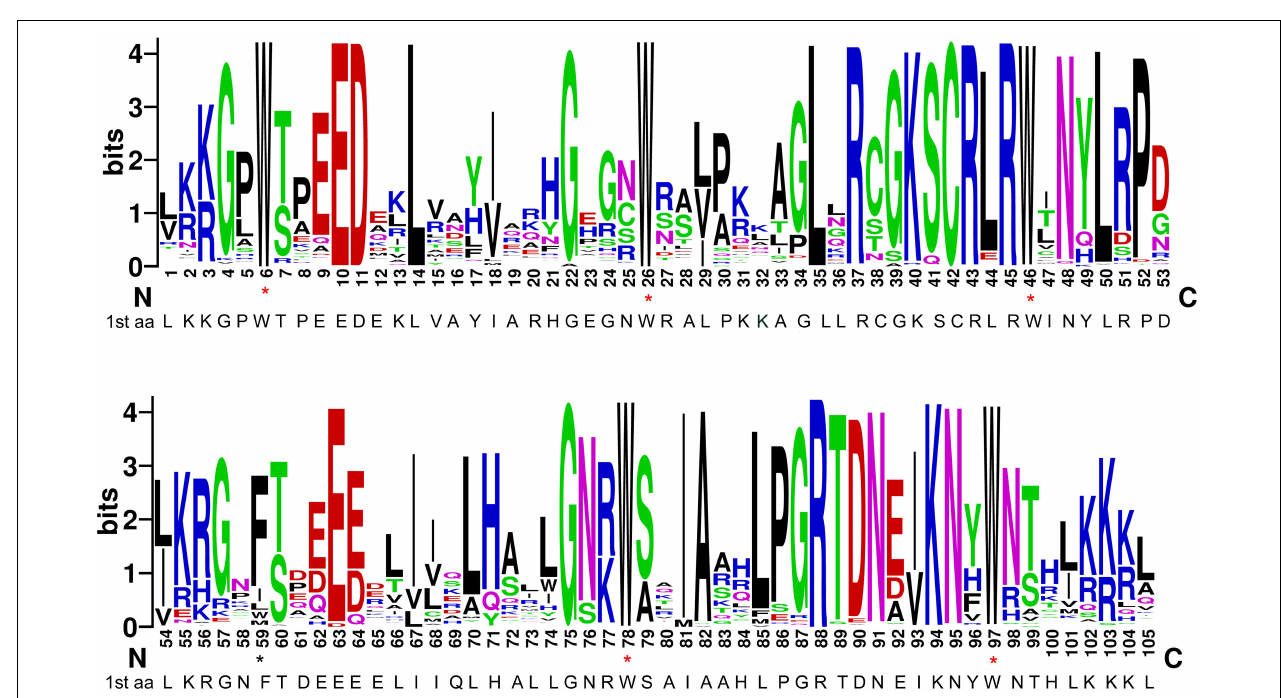
FIGURE 1 | Consensus sequence and level of conservation of R2R3-MYB domains from durum wheat. The sequence logos of the R2 and R3 MYB repeats are based on full-length alignments of all domains. The height of each stack designates sequence conservation at that position and the bit score indicates the relative frequency of the corresponding acid. Conserved tryptophan residues (W) in the MYB domain are marked with red asterisks. Black asterisk highlights the position of the first canonical W in the R3 repeat replaced by hydrophobic phenylalanine or